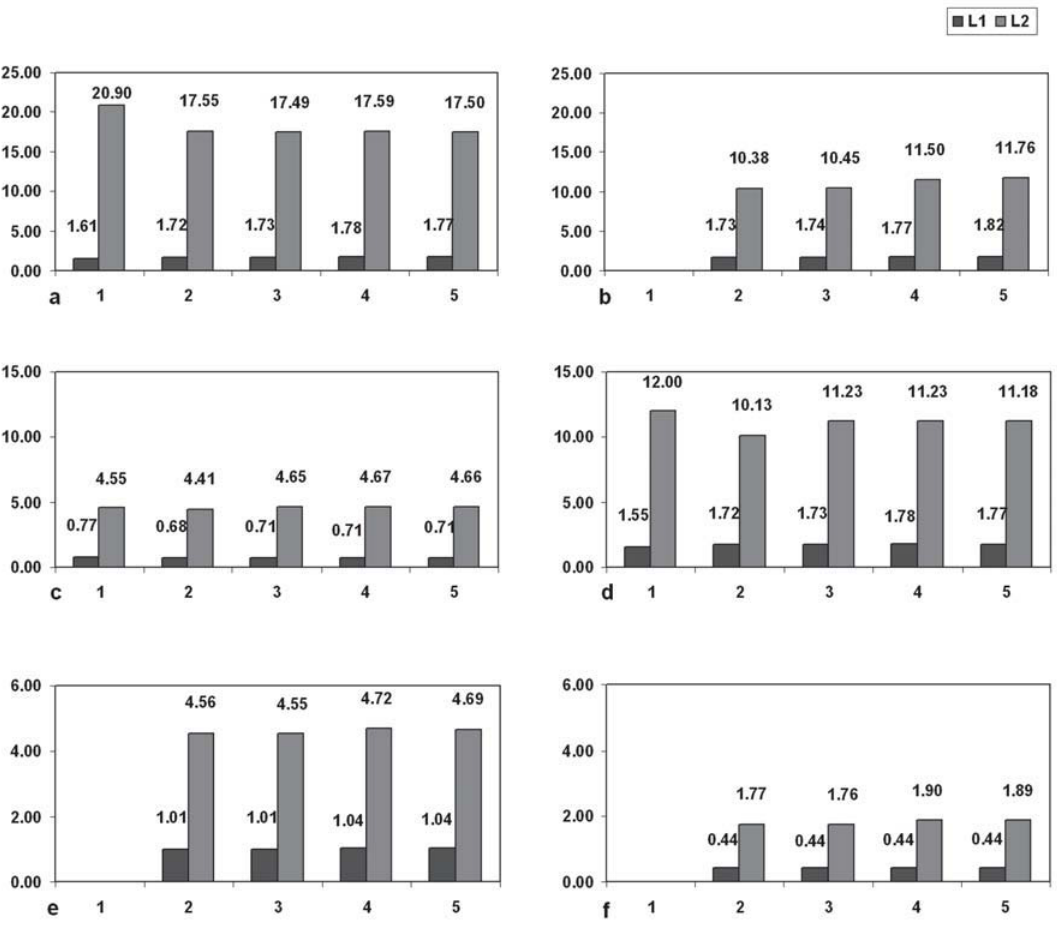
FIGURE 5- Stress values for each group ( 1 to 5 ) and each loading condition ( L1 and L2 ). ( a ) Maximum σ for hybrid layer, ( c ) σ (MPa) for intertubular dentin, ( d ) σ vM σ (MPa) for vM